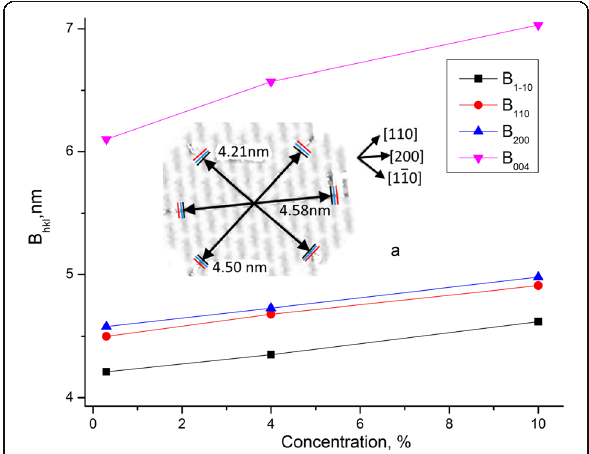
(cid:6) (cid:6) ) T ¼ − 180 o C